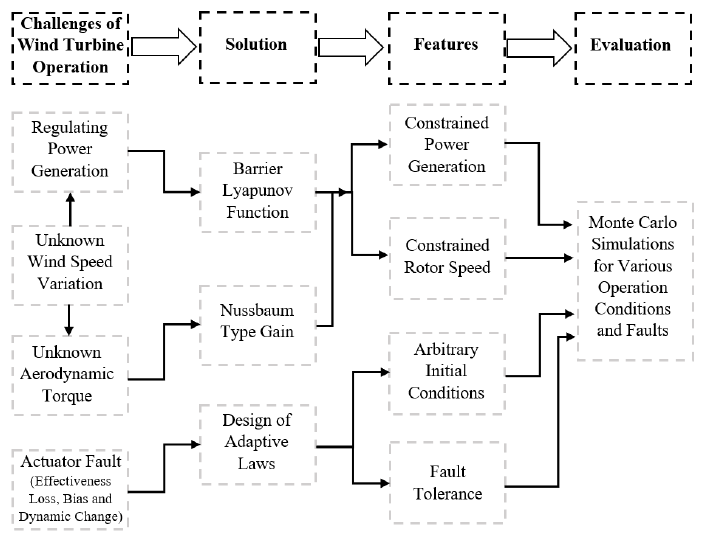
Figure 1. The proposed solution qualitative features.